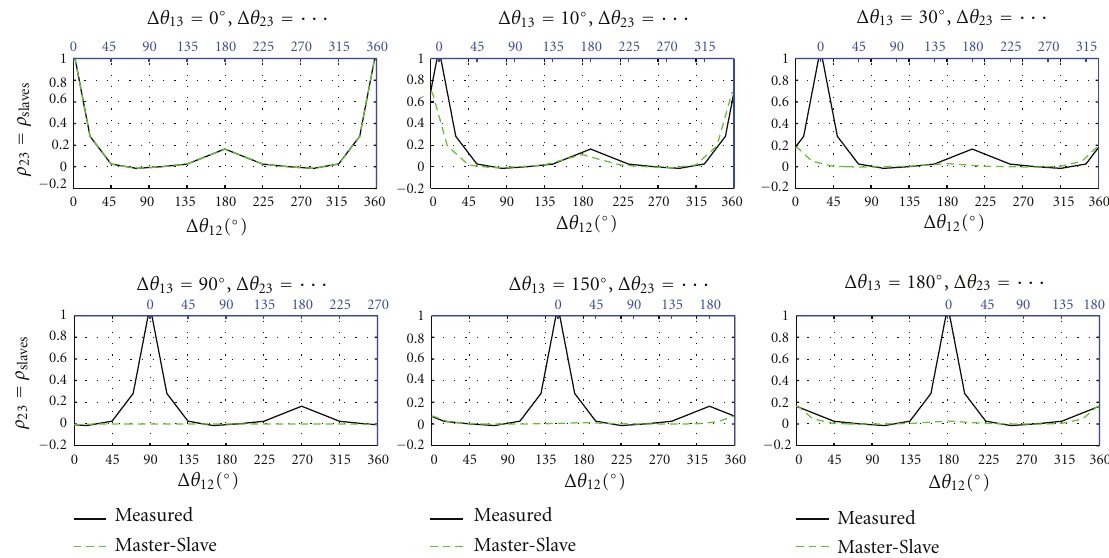
Figure 8: Correlation coe ffi cients between the slaves ( ρ 23 ) with dependency on the azimuth angle separations Δ θ 12 , Δ θ 13 , and Δ θ 23 from measurements and recalculated with Master-Slave. Δ θ 13 is kept constant in each subfigure. The elevation angles are φ 1 = φ 2 = φ 3 = 15 ◦ .